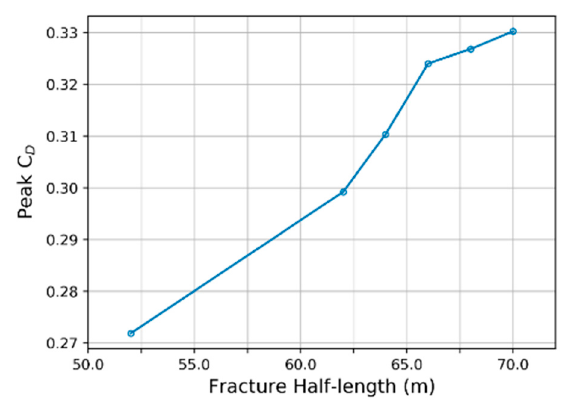
Figure 7. Peak tracer concentration vs. fracture half-length.